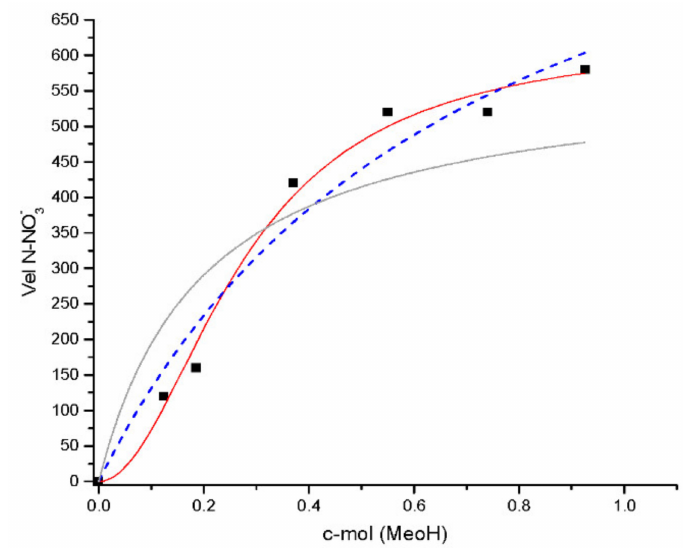
Figure 4. Comparison of kinetic models. Sigmoidal curve by Hill adjustment (red line) n = 2, R 2 = 0.72 and V max = 625 ± 25 (blue dash Line); default adjustment by Origin Pro (software) parameters n = 1, R 2 = 0.92 V max = 1025 ± 25 and (grey line) V max fixed in 625, n = 1, R 2 = 0.92.